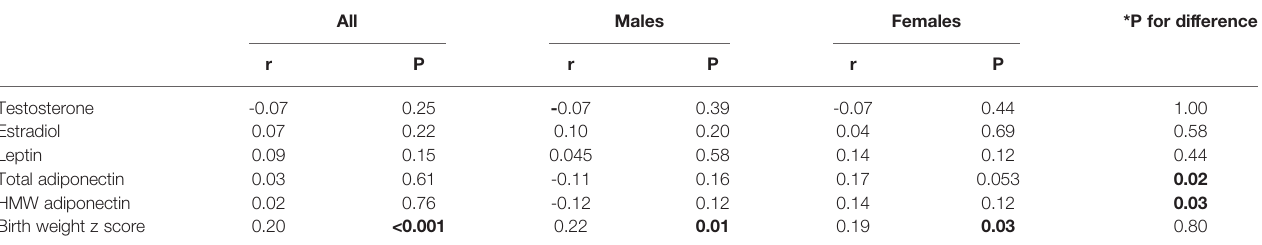
TABLE 4 | Cord blood FABP4 in correlations with testosterone, estradiol, leptin, adiponectin and birth weight (z score) in males and females. All Males Females *P for